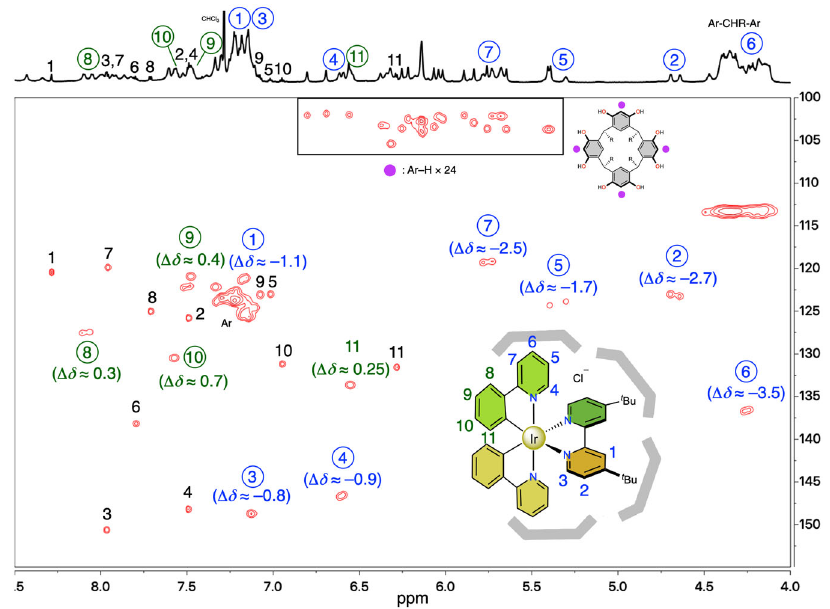
Fig. 3 | 1 H – 13 C heteronuclear single quantum correlation (HSQC) spectrum ( 1 H: 800MHz, CDCl 3 , 298K) of the mixture of [2a]Cl and (1a) 6 ⊃ ([2a]Cl). The cross